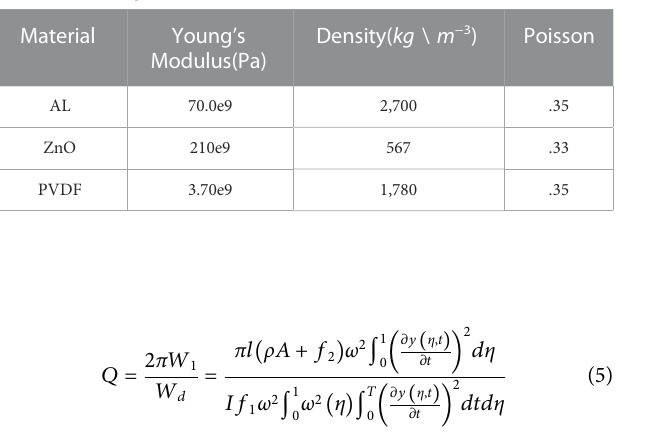
TABLE 1 Material parameter table.